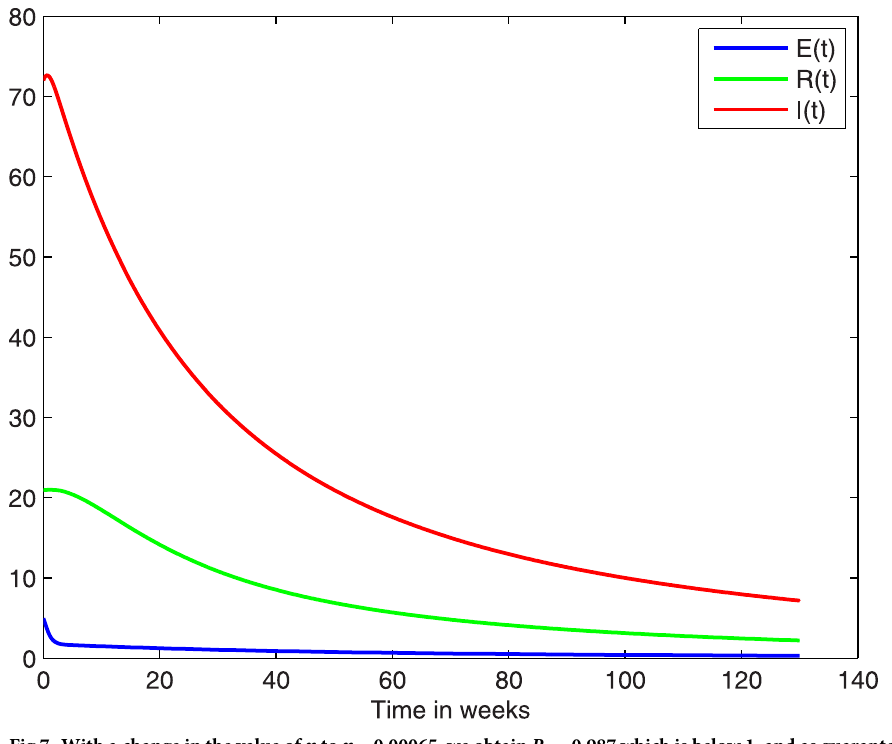
Table 1, except for η which has been reduced to 0.00065 (instead of 0.0014), and this gives R 0.987 which is below